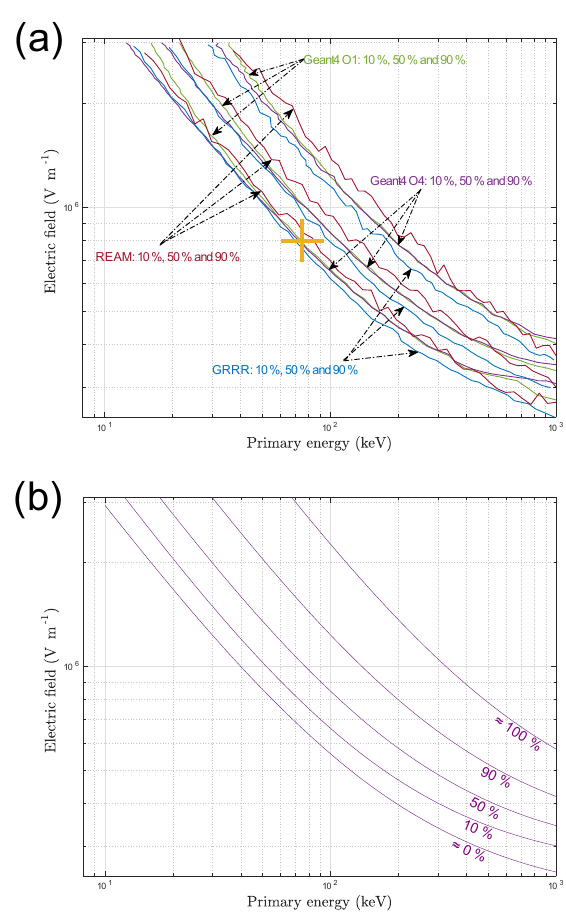
Figure 2. (a) Relativistic avalanche probability comparison be- tween GRRR, REAM, O4 and O1. It shows three contour lines at 10%, 50% and 90% as functions of seed (primary) energy (cid:15) and electric field magnitude E . These contours are derived from the full probability scans that are presented in the Supplement (Sect. S5). The cross at { (cid:15) = 75keV , E = 0 . 80MVm − 1 } highlights the point where we studied the effect of the simulation stepping parameters (for O4 and O1) on the probability; see Fig. 1. (b) Five contour lines indicating the 0%, 10%, 50%, 90% and 100% probabili- ties to generate a RREA as function of (cid:15) and E for the Geant4 O4 model for which we could run a very large number of initial electrons ( > 50000) to obtain curves with a very low noise